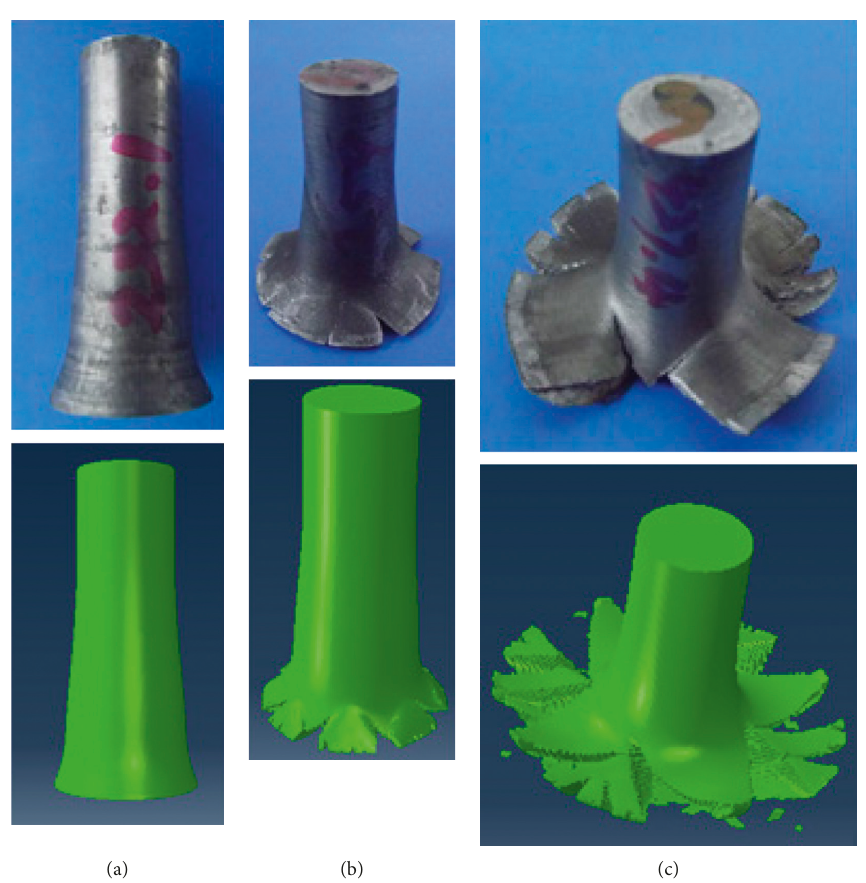
Figure 1: Comparison of numerical simulation and Taylor test results. (a) v � 232 . 1 m/s. (b) v � 232 . 1 m/s. (c) v � 437 . 4 m/s.